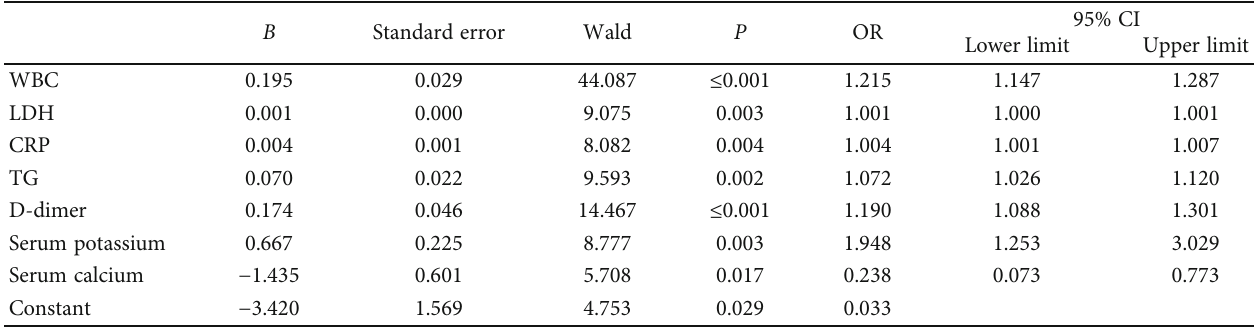
Table 6: Results of logistic regression analysis of independent prognostic factors for MSAP and